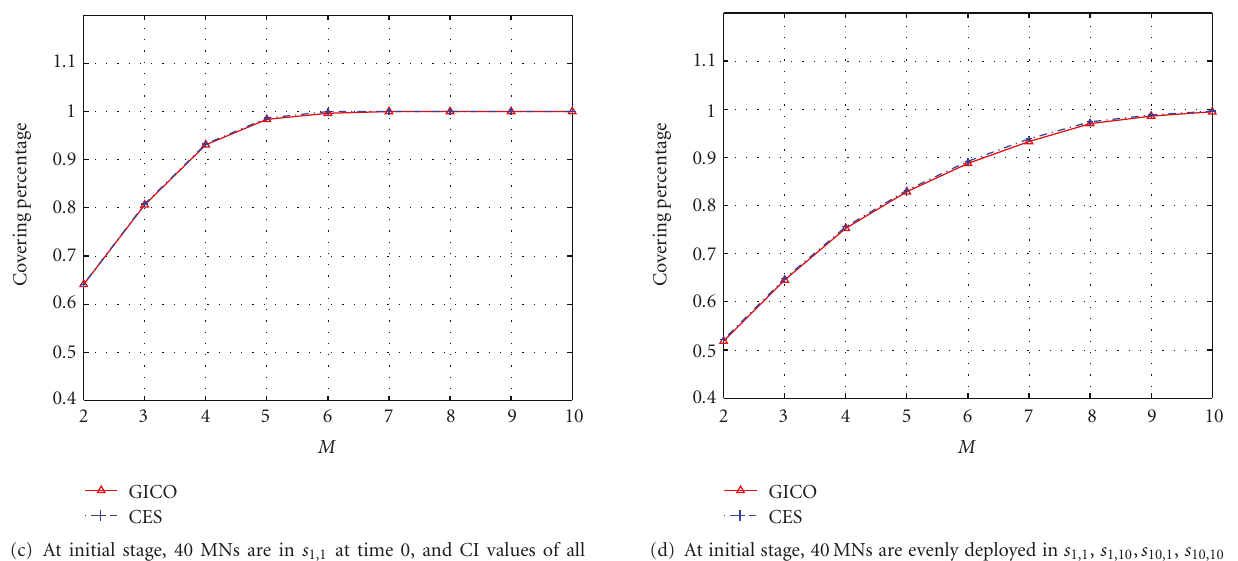
Figure 9: Average covering percentage over the entire relief process versus di ff erent number of RNs in four scenarios. r = 1 . 5 L , C =